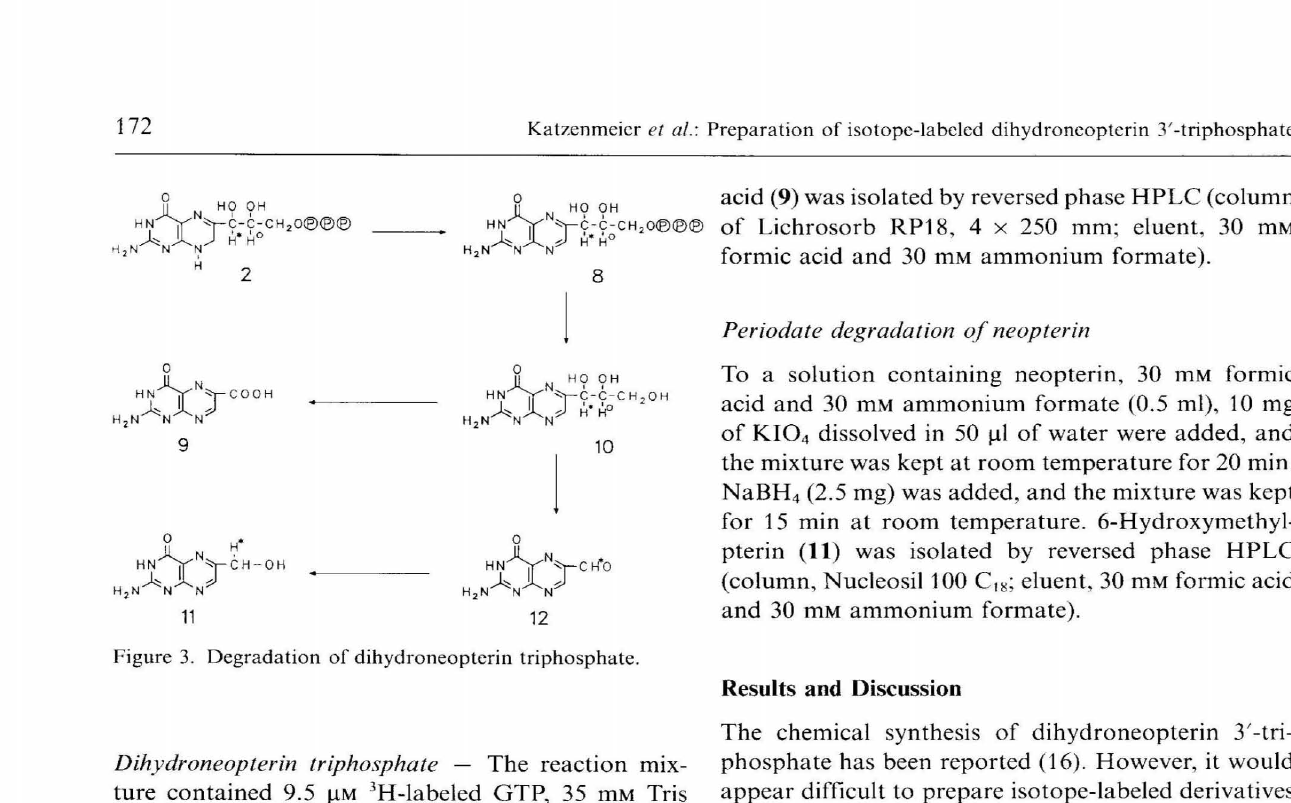
Figure 3. Degradation of dihydroneopterin